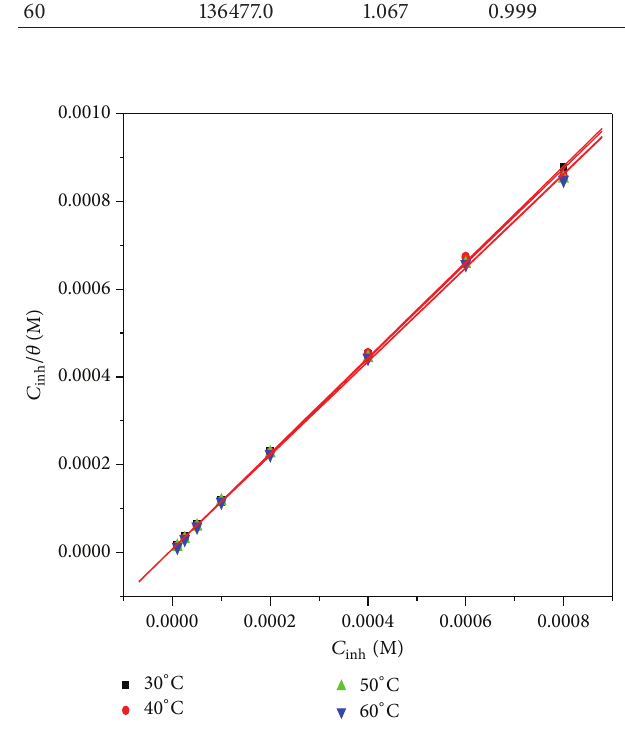
Figure 7: Langmuir’s adsorption isotherm of HIBH on mild steel in 1M HCl at different